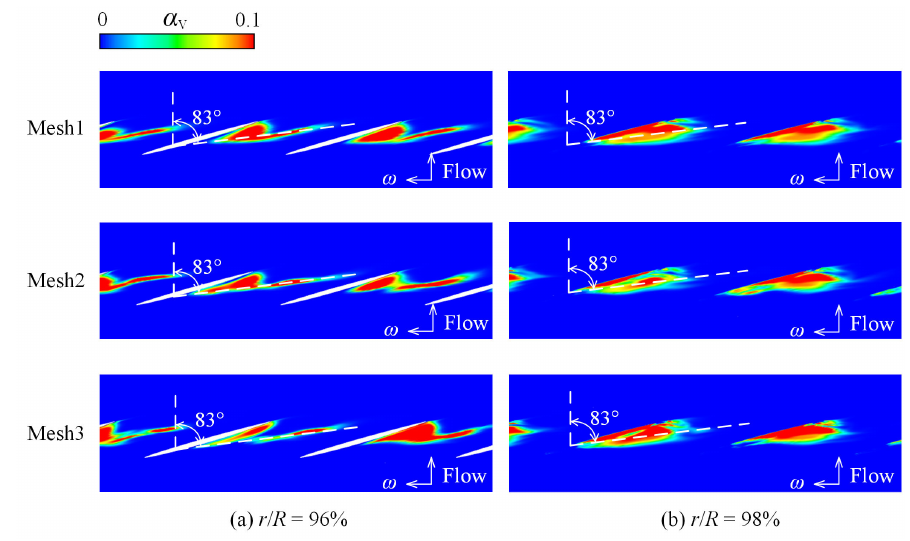
Figure 5. Contours of vapor volume fraction on spanwise sections.